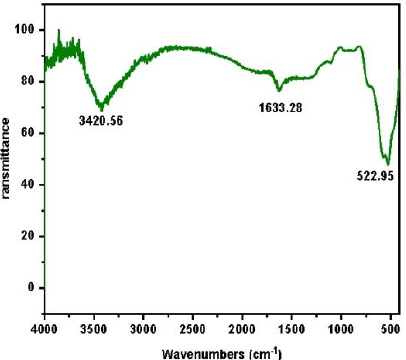
Figure 6. FT ‐ IR spectrum of MnO 2 /MXene composite films.